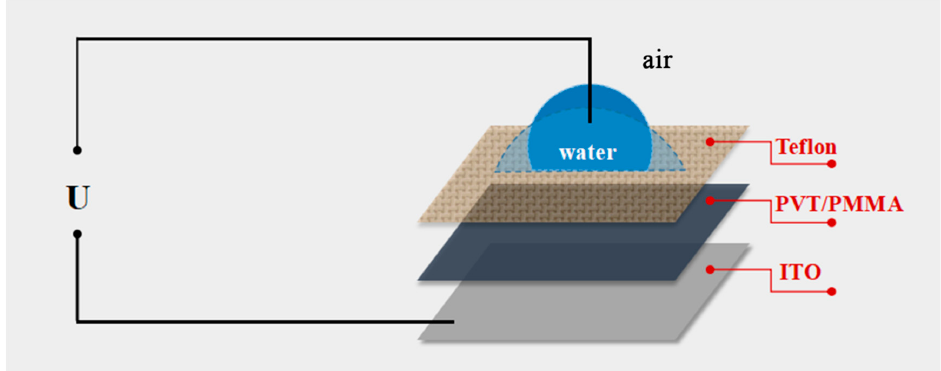
Figure 1. Schematic of the electrowetting experiment setup in the air ambient condition: ITO as the electrode; PVT/PMMA as the dielectric layer; Teflon as hydrophobic layer; water as the aqueous